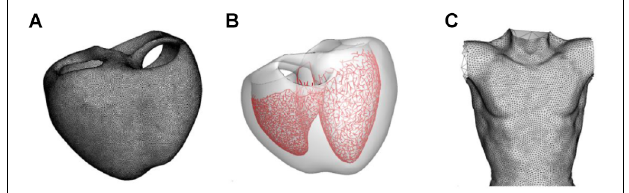
FIGURE 1 | Models of the ventricle and torso used in the present study. (A) Grid of the ventricular model. (B) Model of the Purkinje fiber network. (C) Model of the